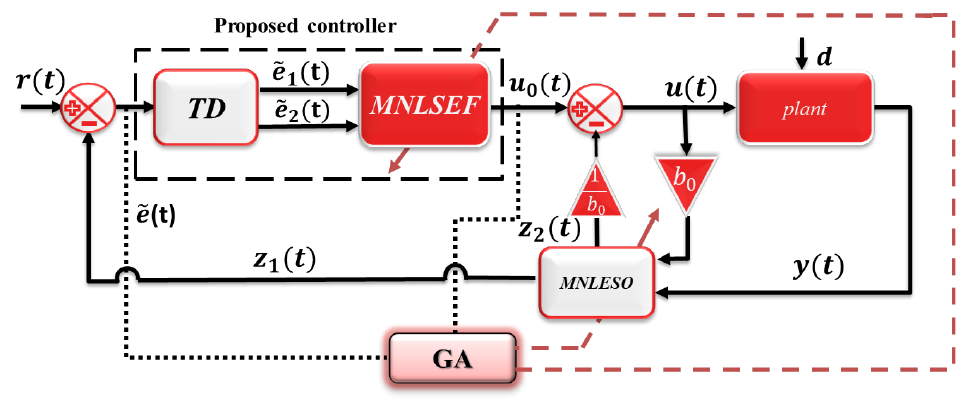
Figure 3. MADRC with GA. Table 4. Sampled parameters of the four-tank system [1].